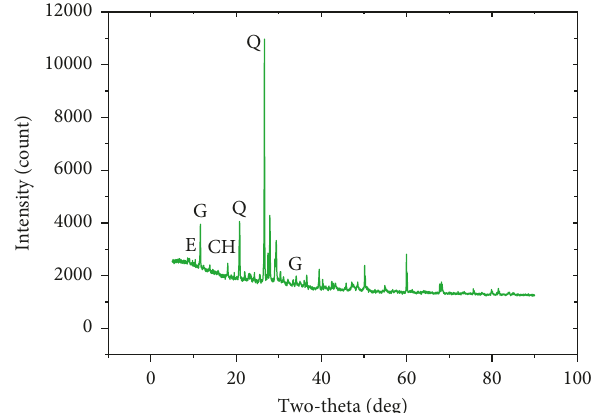
Figure 13: XRD of powder specimen from DW-1 specimen after 63 days sulfate attack. (E (cid:31) ettringite, CH (cid:31) calcium hydroxide, G (cid:31) gypsum, Q (cid:31)